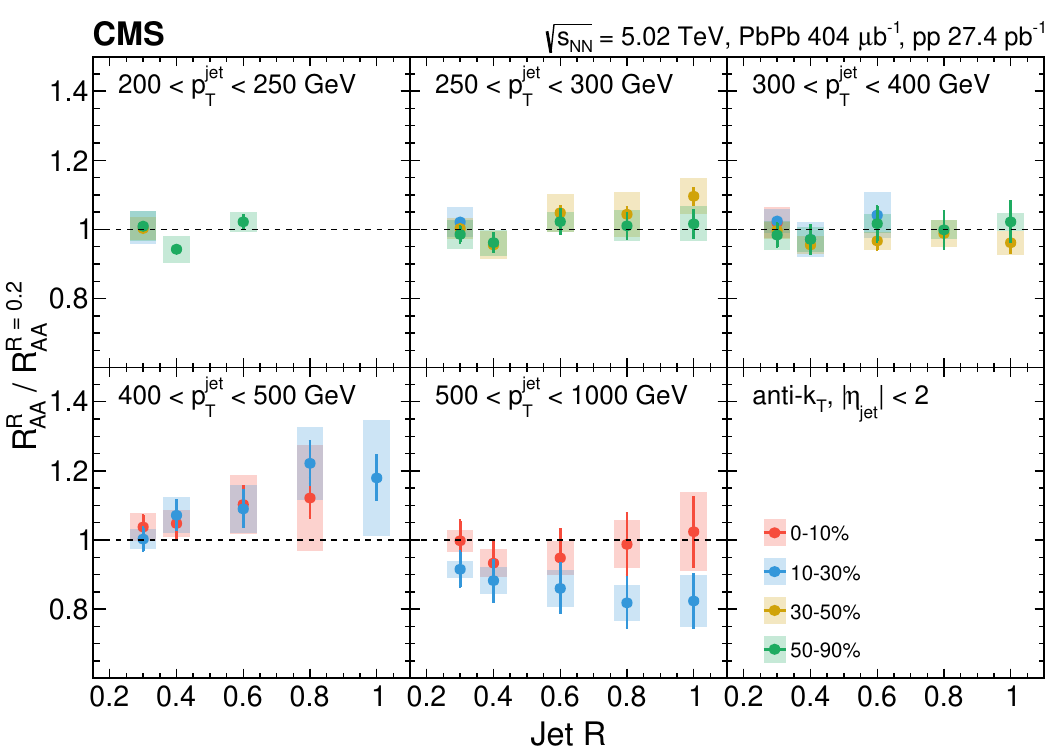
ratio for jets with | η jet | < 2 . 0 as a function of R for R = 0 . 3 – 1 . 0 with respect Figure 8 . The R AA to R = 0 . 2 , in various event centrality classes and p jet ranges. The statistical uncertainties of data T are shown as the vertical lines, whereas the systematic uncertainties are shown as the shaded